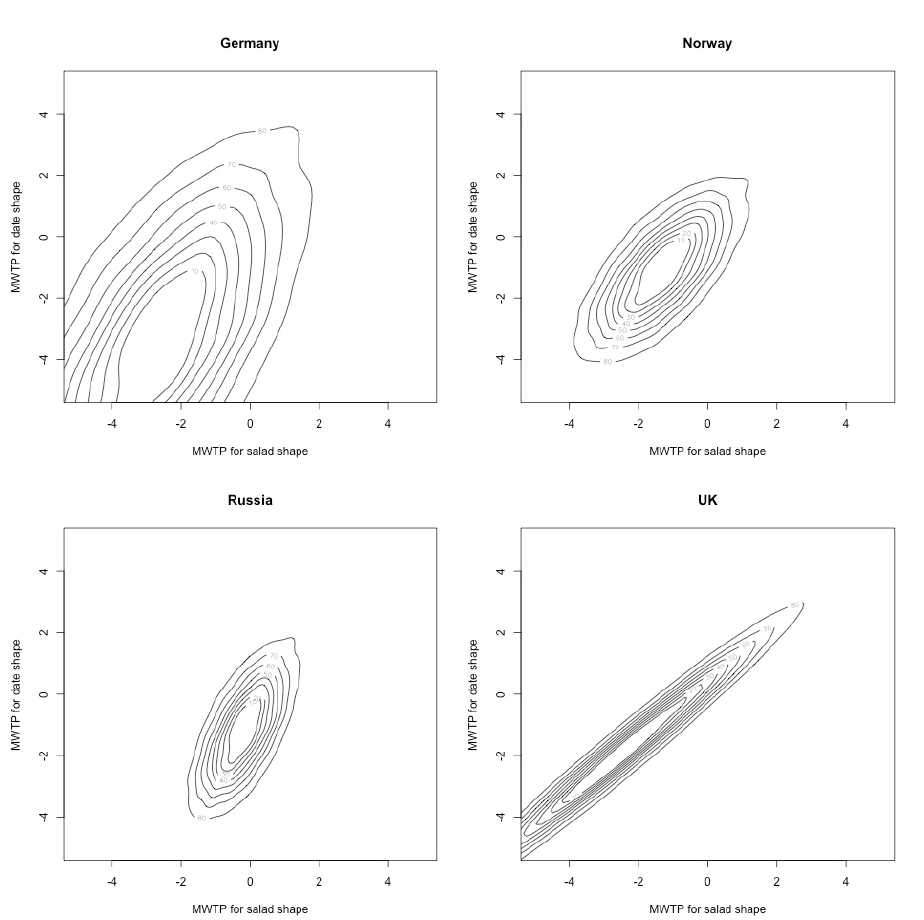
Figure 4. Iso-Quantile Plots of Bivariate Kernel Density distributions for MWTP estimates for salad and date-shaped tomatoes in the four